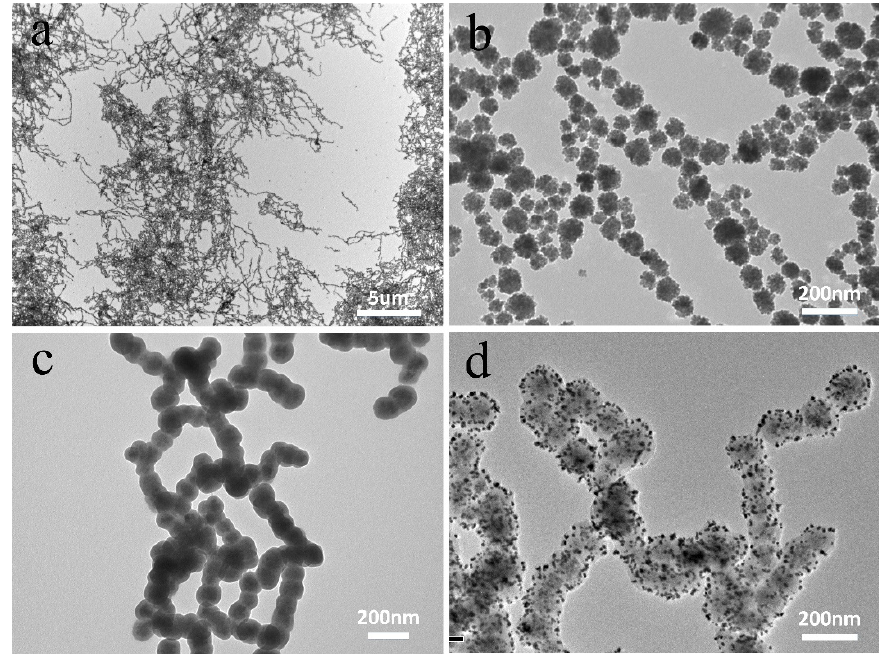
Figure 3. TEM images of the Fe 3 O 4 ( a , b ), Fe 3 O 4 @SiO 2 ( c ), and Fe 3 O 4 @SiO 2 @Au/PDA ( d ) nanochains.